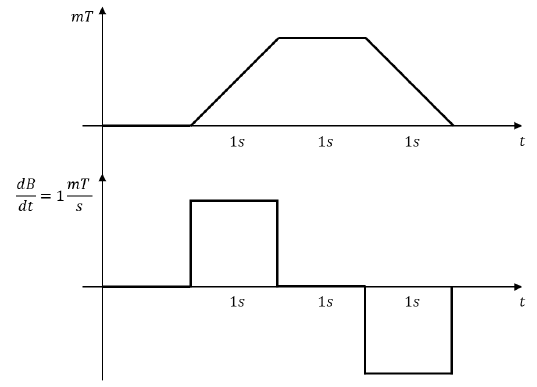
Figure 14. Desired minimum detectable signal scenario.